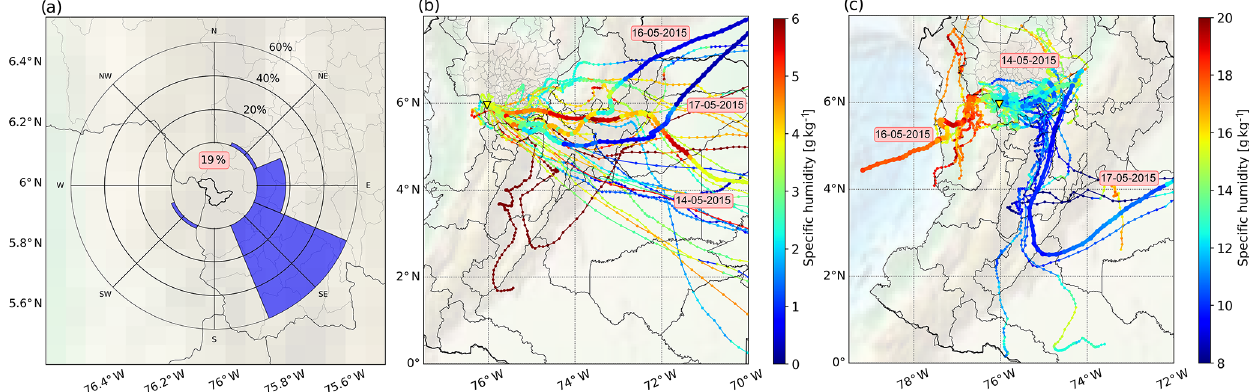
Figure 7. (a, b) Similar to Fig. 6 for May 2015. (c) Back-trajectory and specific-humidity analysis arriving at 850hPa over the La Liboriana